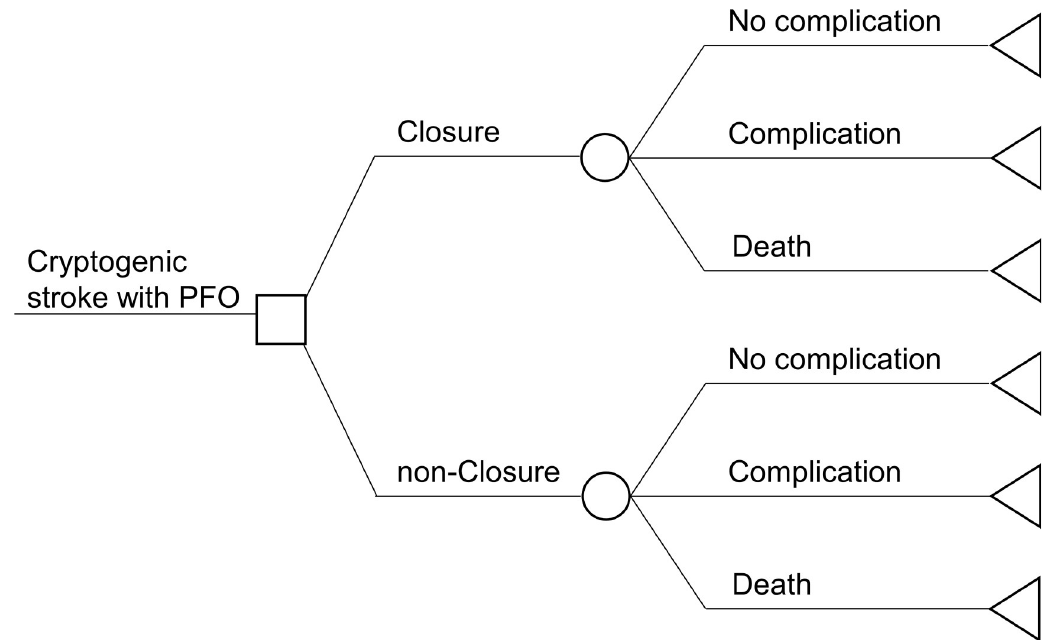
Fig 1. Decision tree. A decision tree shows that a patient who had a PFO enters this model after a cryptogenic stroke and is assigned either a PFO closure or medical treatment. PFO closure has three possible outcomes: complication, non-complication, or death. Abbreviations. PFO, patent foramen